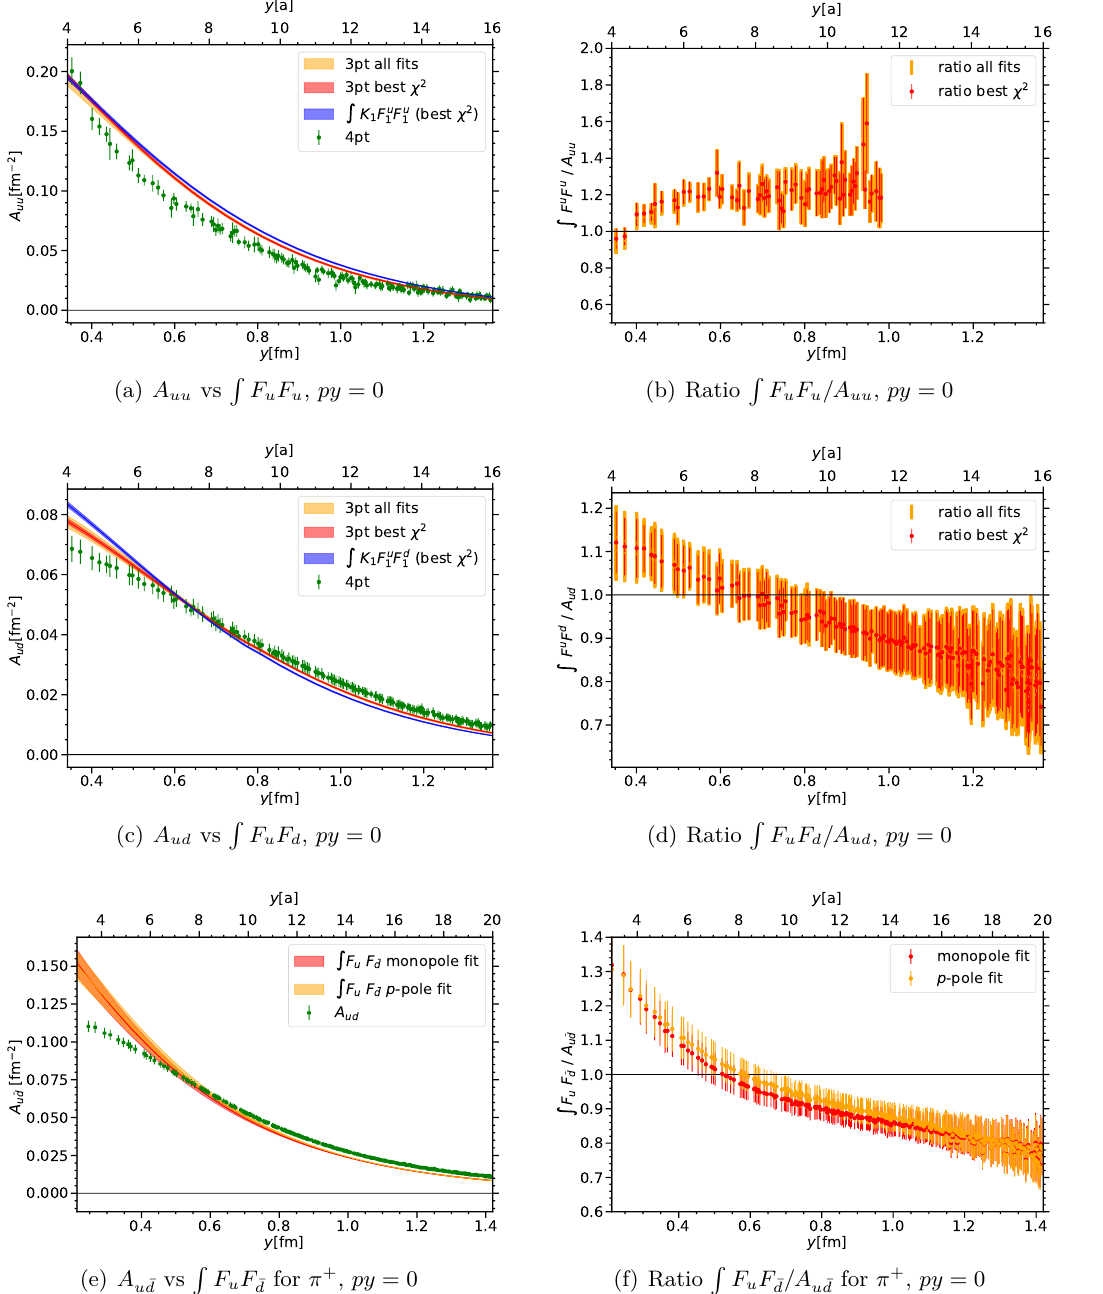
Figure 27 . Left: comparison of the twist-two functions A uu (a) and A ud (c) (green points) and the factorization results obtained by the integral (5.13). The red curve is obtained from the form factor fits with best χ 2 / dof . The orange band represents the envelope of the error bands of the different fits. Right: ratio of the form factor integral and the corresponding twist-two functions, again shown for A (b) and A (d). In the panels (a) and (c) we also present the integration uu ud result taking into account only the first term (5.13) (blue curve). In panel (e) and (f), we show the corresponding results for the π + obtained in [67] for two different